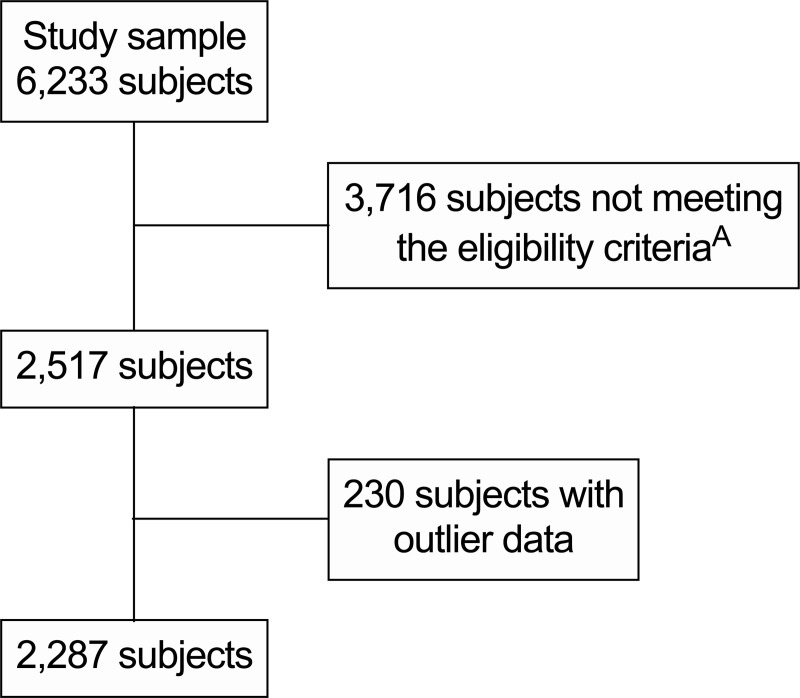
Flow diagram for selection of participants.A18 to <65 years old, body mass index ≥18.5 kg/m2, along with complete data for blood pressure, circulating triglycerides, circulating glucose, circulating high-density lipoprotein cholesterol and waist circumference.